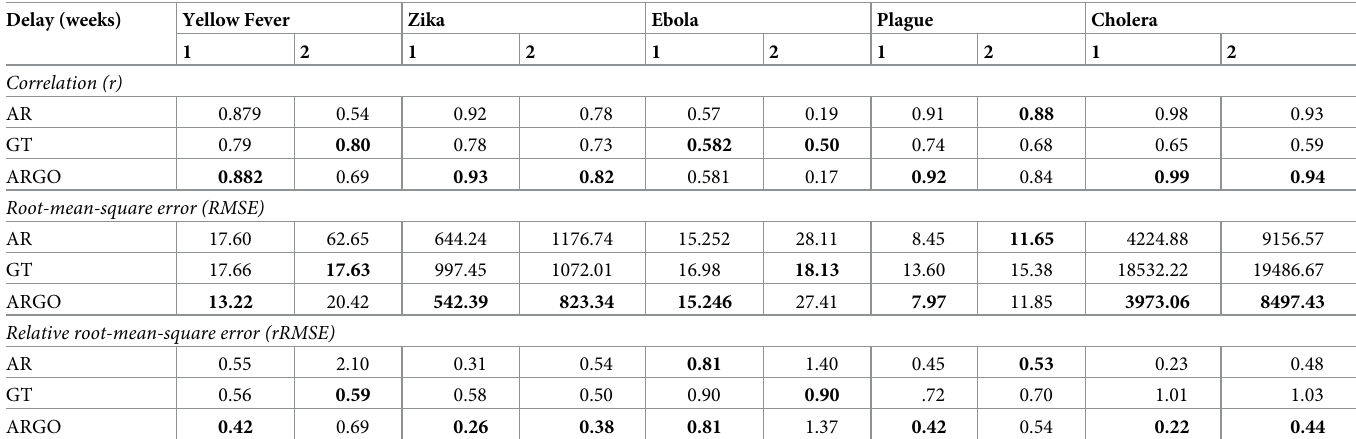
Table 1. Evaluations of three computational models (AR, GT, and ARGO) across five outbreaks, based on correlation ( r , Panel A), root-mean-square error (RMSE, Panel B), and relative root-mean-square error (rRMSE, Panel C). The result of the best-performing model for each prediction scenario and metric is bolded. It is impor- tant to note that the units of the error (RMSE) are different given that the magnitude of each outbreak was different. The relative error, however, is comparable across outbreaks.